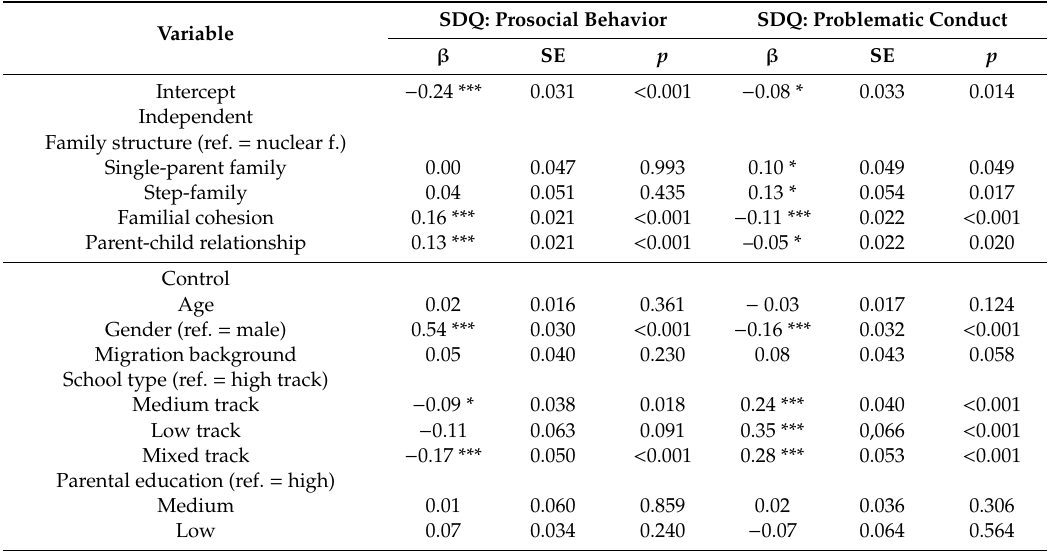
Table 3. Results for the Strengths and Di ffi culties Questionnaire (SDQ) scales, prosocial behavior and problematic conduct (linear regressions). SDQ: Prosocial Behavior SDQ: Problematic Conduct Variable